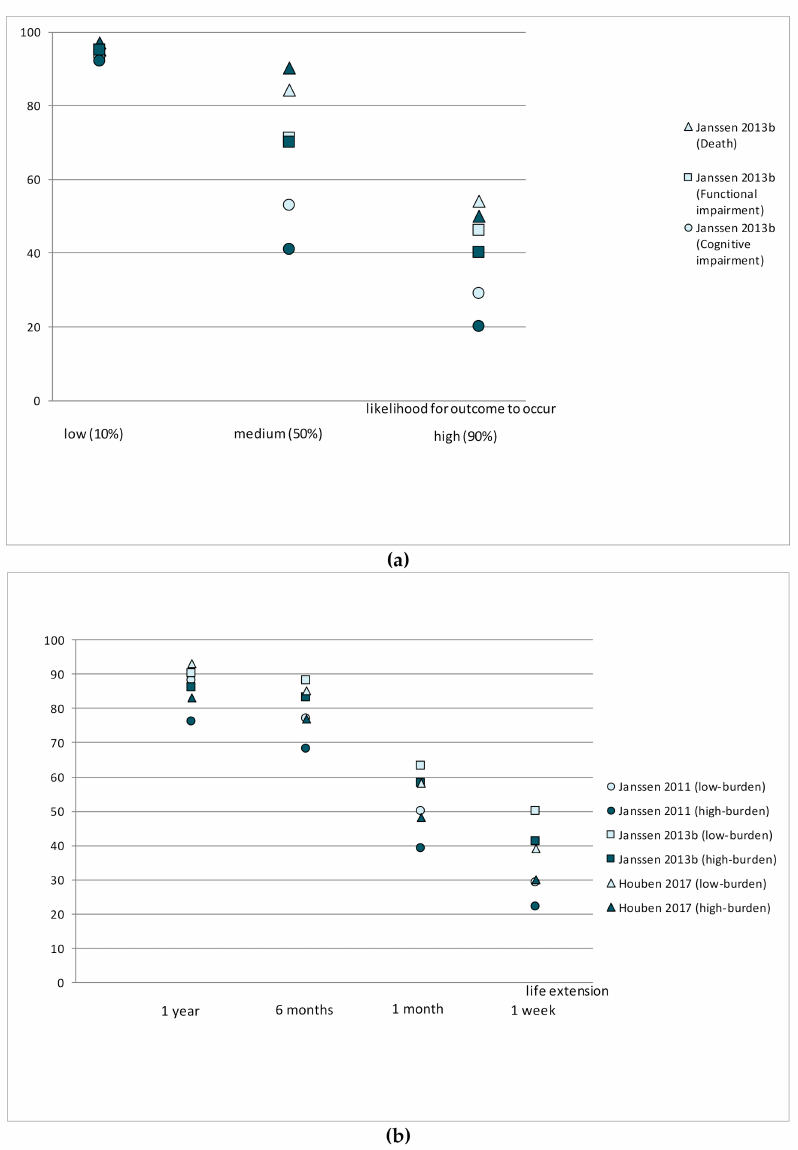
Figure 2. Willingness to receive life-sustaining treatments in different scenarios: ( a ) Compares preferences (%) from two studies assessing the willingness to receive LSTs depending on the risk of death, cognitive or functional impairment (%); ( b ) Compares preferences (%) from three studies assessing the willingness to receive LSTs depending on life extension and treatment